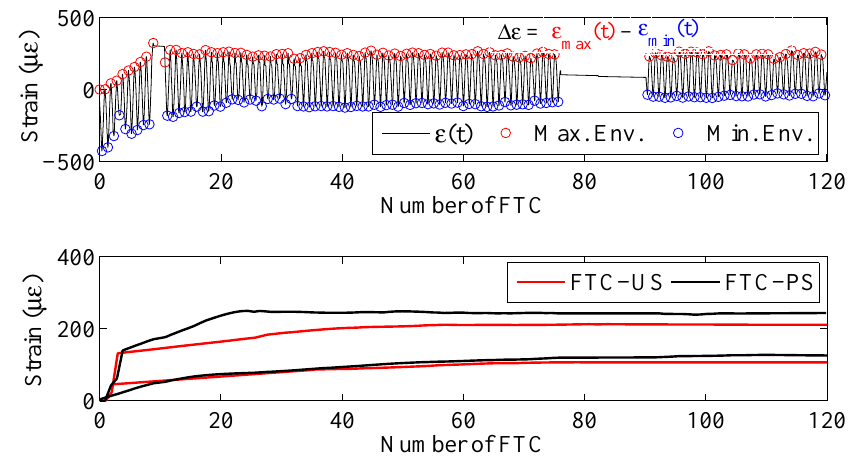
Figure 12. Top : Strain time-history of an FOS sensor placed at the free-length of a prestressed block, along with its maximum and minimum envelope during FTC; bottom : maximum strain envelope measured at the free-length during FTC for unstressed and prestressed blocks.